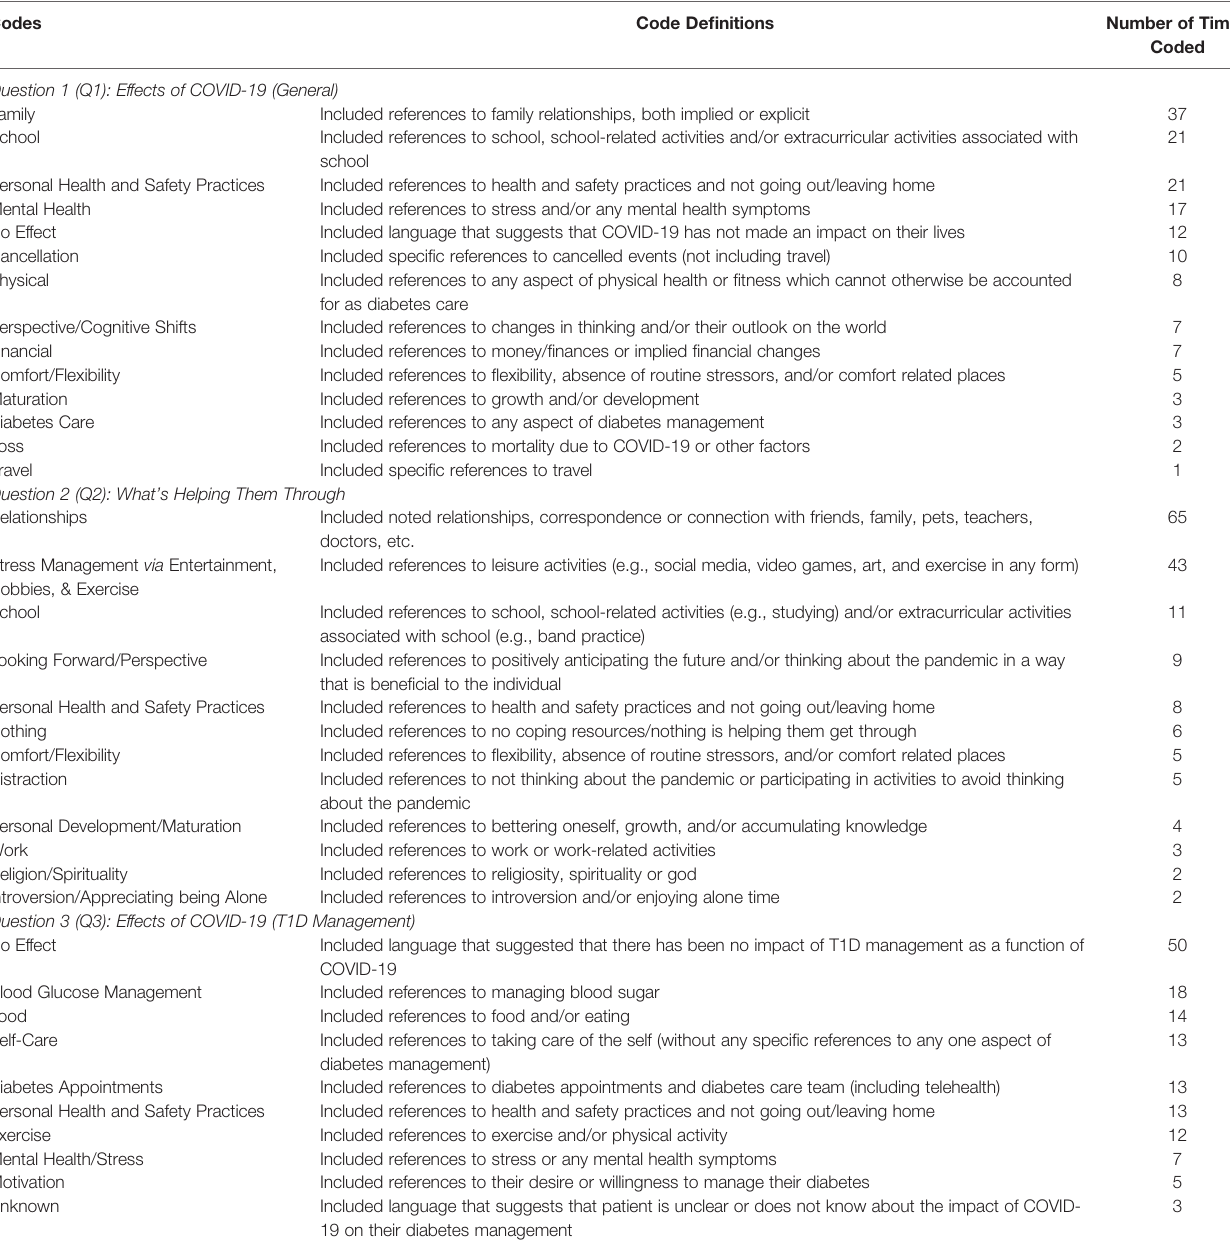
TABLE 2 | Code categories, code de fi nitions, and number of times coded.